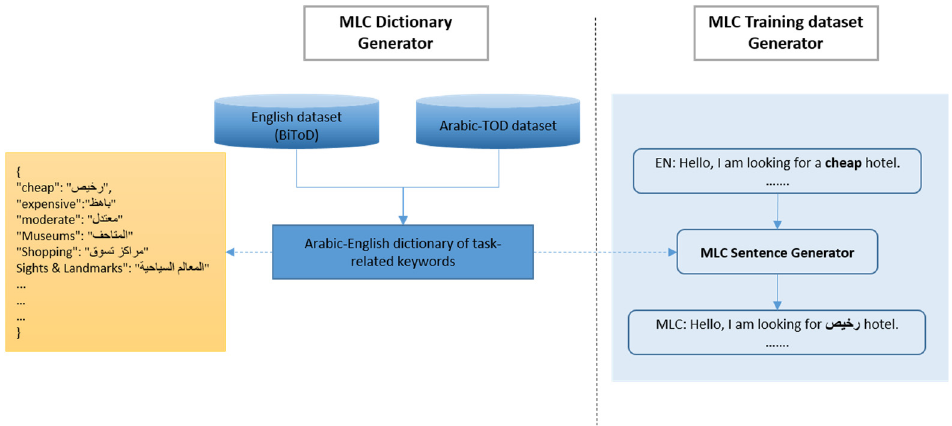
Figure 1. Mixed-language context (MLC) generation process.